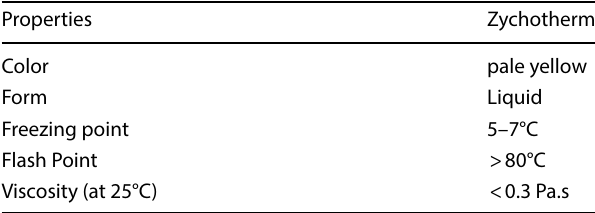
Table 3 Physical and chemical properties of Zycotherm